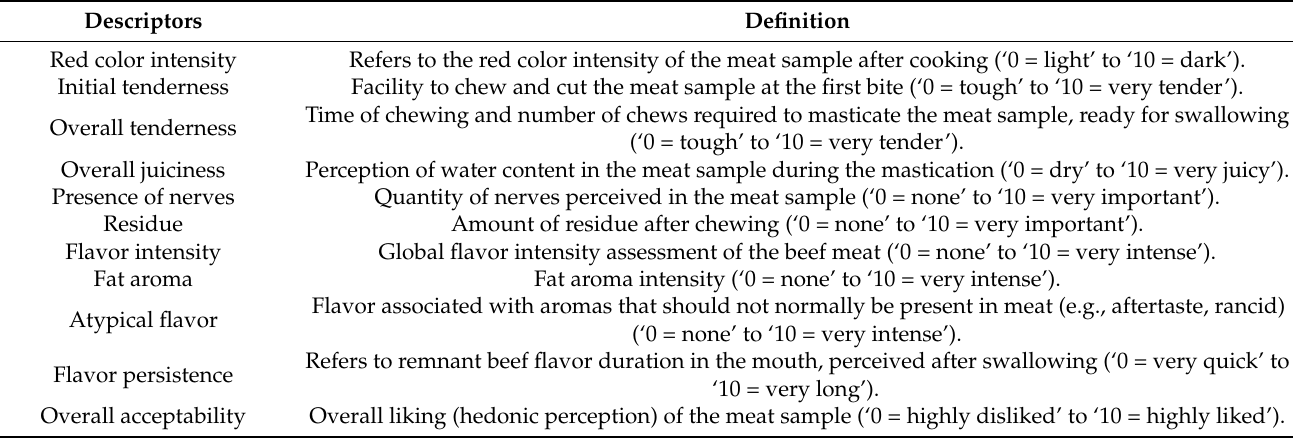
Table 2. Definitions of the sensory and hedonic